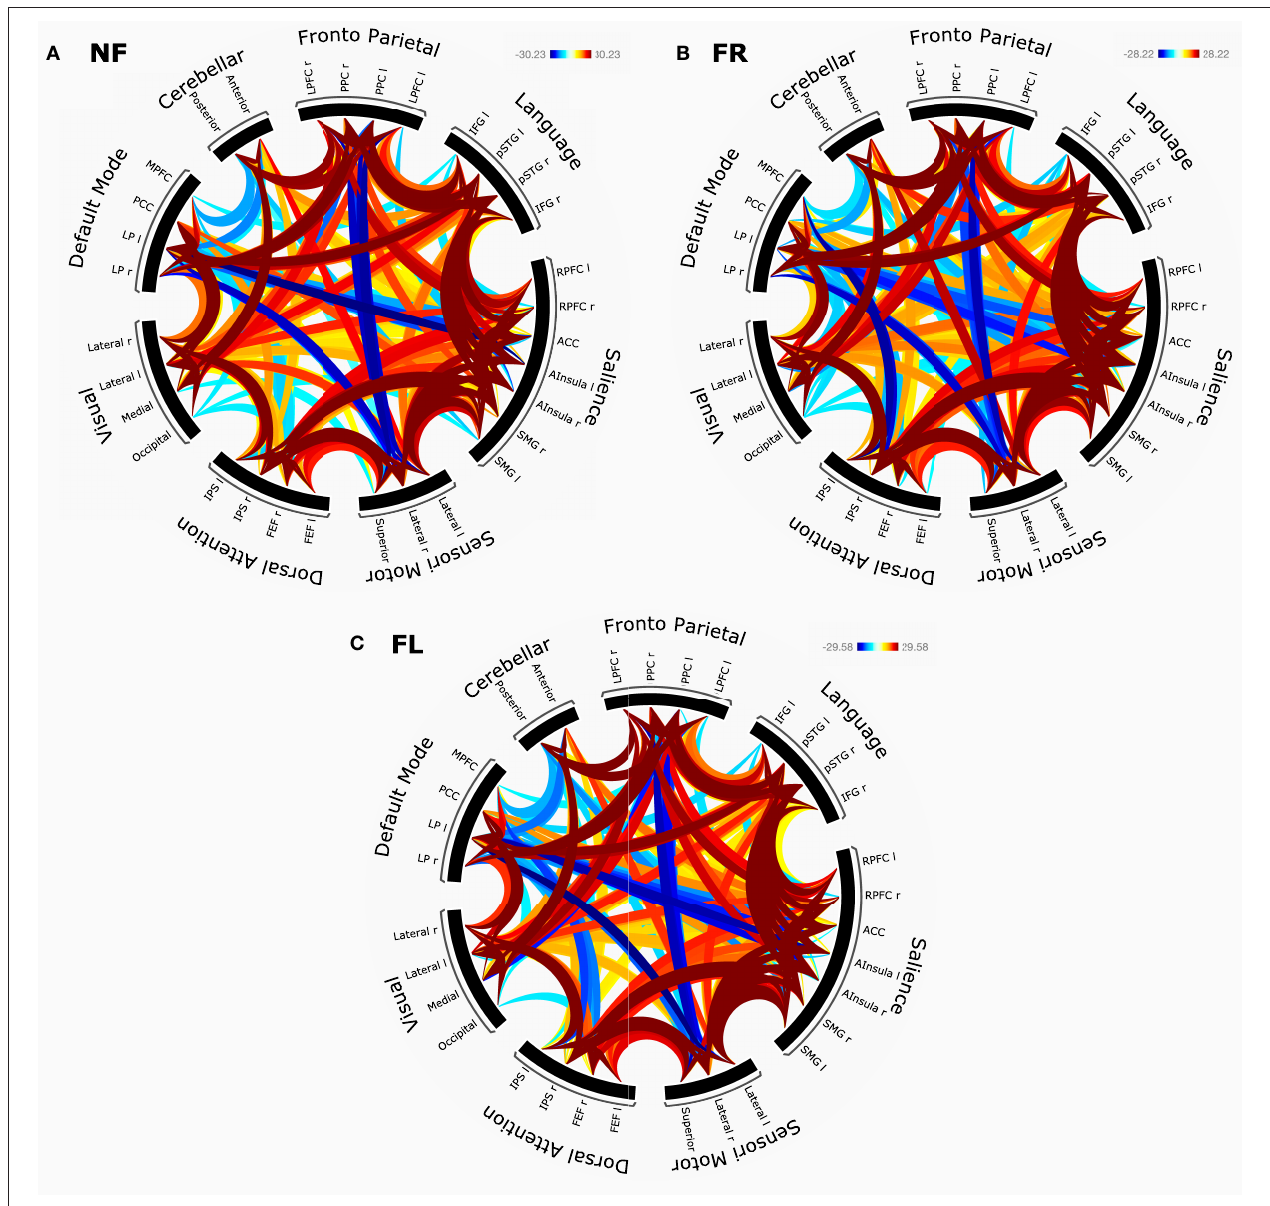
FIGURE 4 | (A–C) The panel shows corresponding network connectivity rings for eight cortical networks, split for NF ( A , top left), FR ( B , top right), FL ( C , bottom) attention instruction condition.